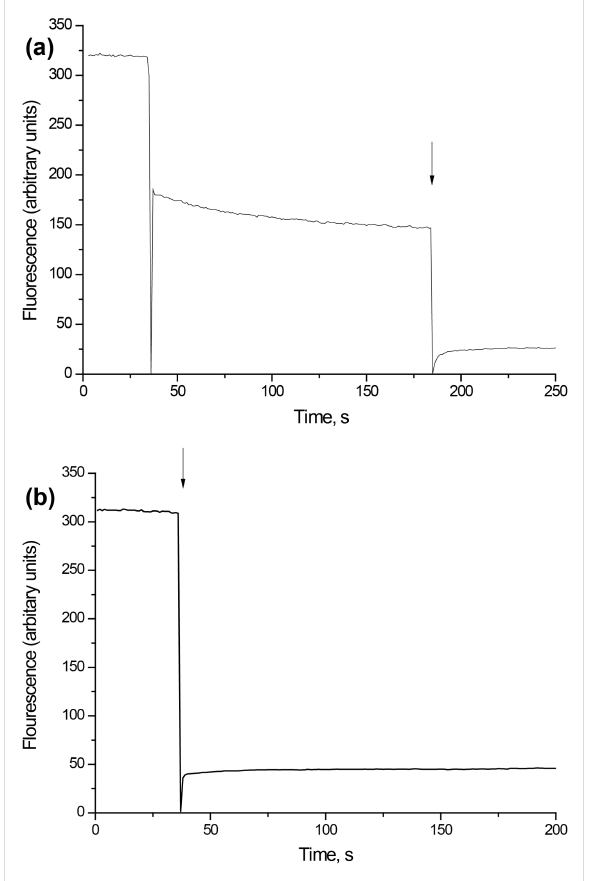
Figure 6: (a) Acidification of the synaptosomes in the presence of D-mannose-coated γ -Fe 2 O 3 nanoparticles. The synaptosomes were equilibrated with acridine orange (5 µM); when the steady level of the dye fluorescence had been reached, nanoparticles (250 µg/mL) were added (arrow). (b) Acridine orange fluorescence after the addition of D-mannose-coated γ -Fe 2 O 3 nanoparticles (without synaptosomes). Each trace represents four experiments performed with different